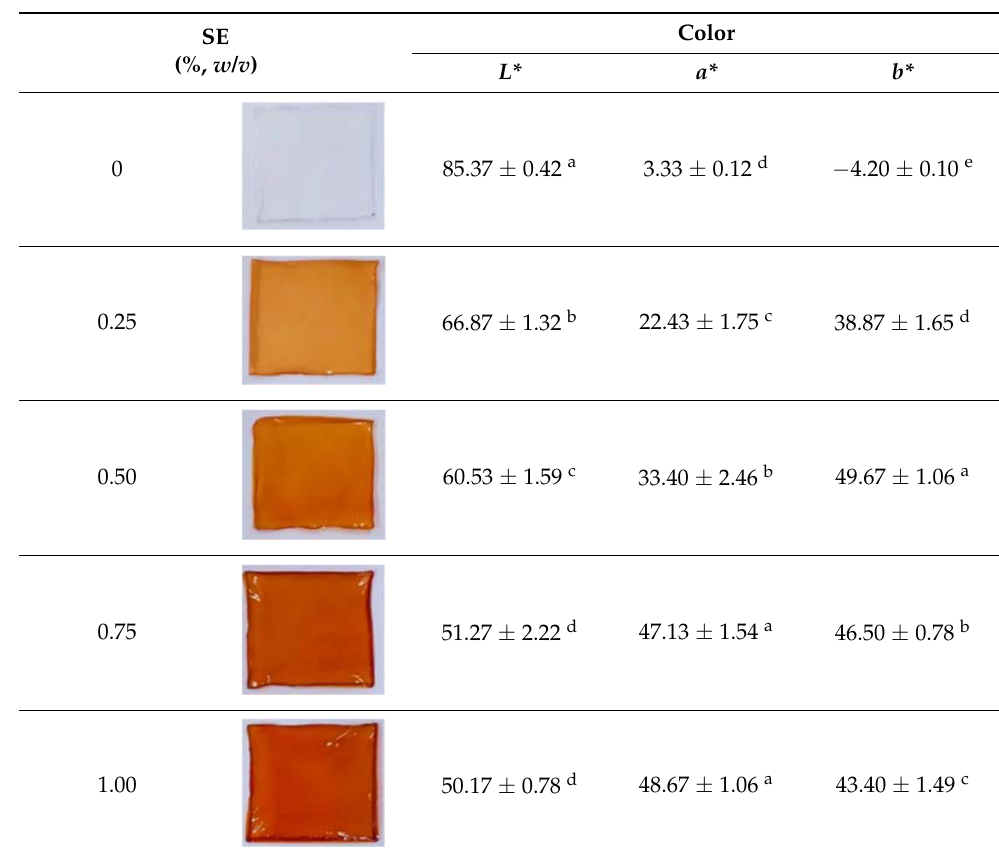
Table 2 . Film appearance and color of gelatin films incorporated with sappan heartwood extract ( SE ) at different concentrations .